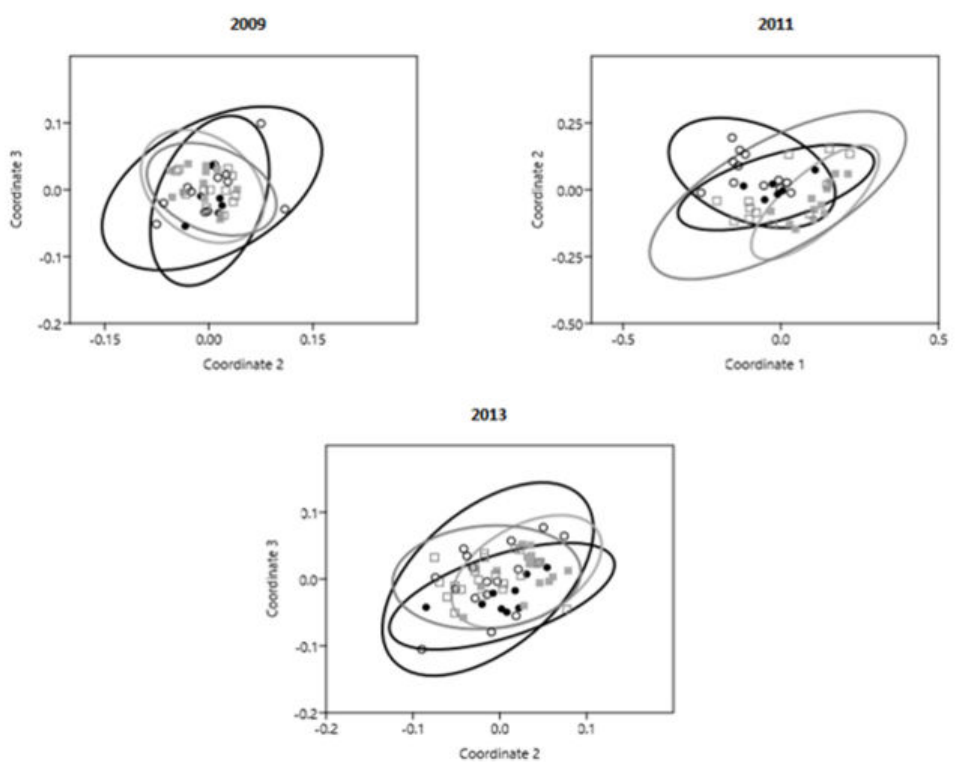
Figure 4. Non-metric multidimensional scaling (nMDS) ordinations with 95% confidence ellipses per site ( Cabo de las Huertas —CH, black solid circles; Santa Pola —SP, black open circles; Tabarca II—T2, gray solid squares; Tabarca III—T3, gray open squares). Table 4. Analysis of similarity (ANOSIM) results examining within-year and cross-year variability of fish community composition among study sites ( Cabo de las Huertas —CH; Santa Pola —SP;